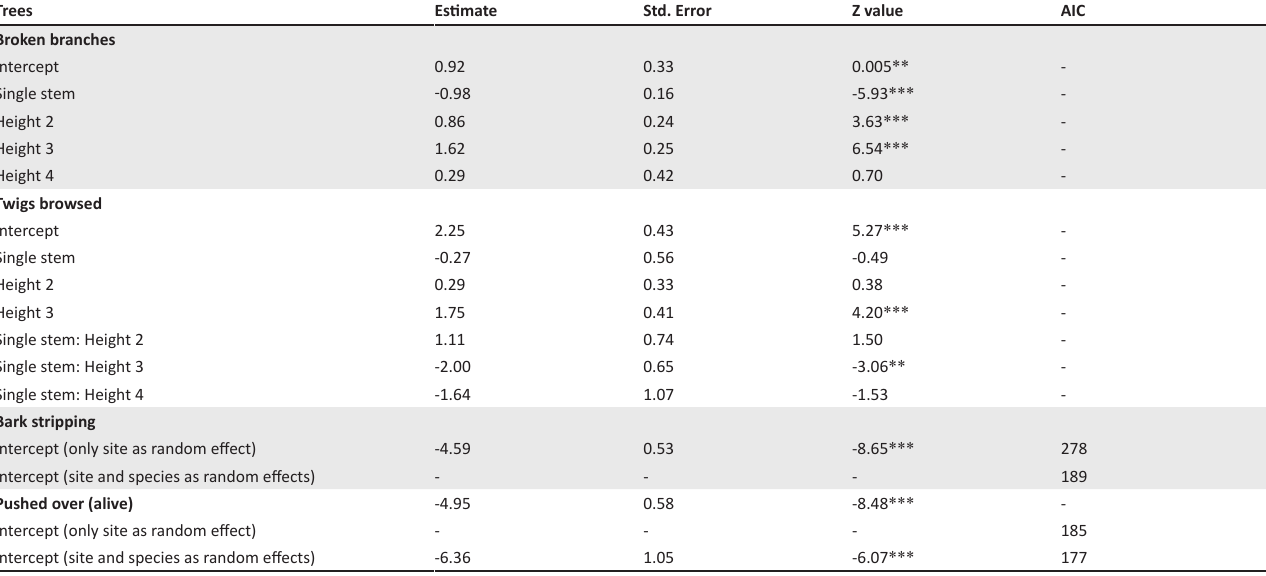
TABLE 3-A1: Best fit model results of the relationships between proportions of trees with specific browser damage and the tested predictors using Generalised Linear Models (with binomial errors). Trees Estimate Std.